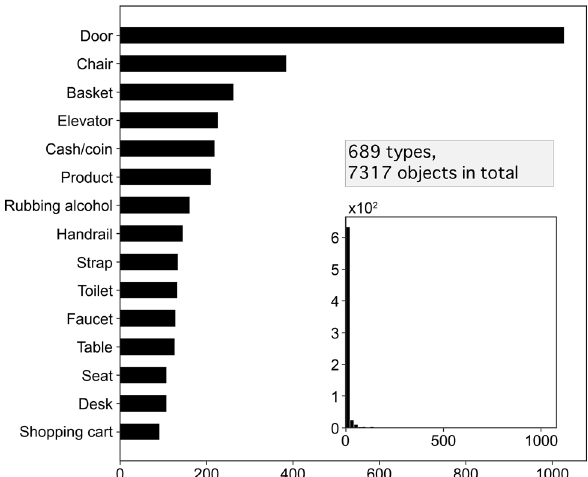
Figure 2. Distribution of the 15 most touched objects (bins: 50). There were 689 types of objects, and a total of 7317 object items were touched. The histogram (bins: 50) has a structure in which objects with a small occurrence frequency account for the majority of the total occurrence frequencies (i.e., 323 types of objects with an occurrence frequency of 1, and 94 types of objects with an occurrence frequency of